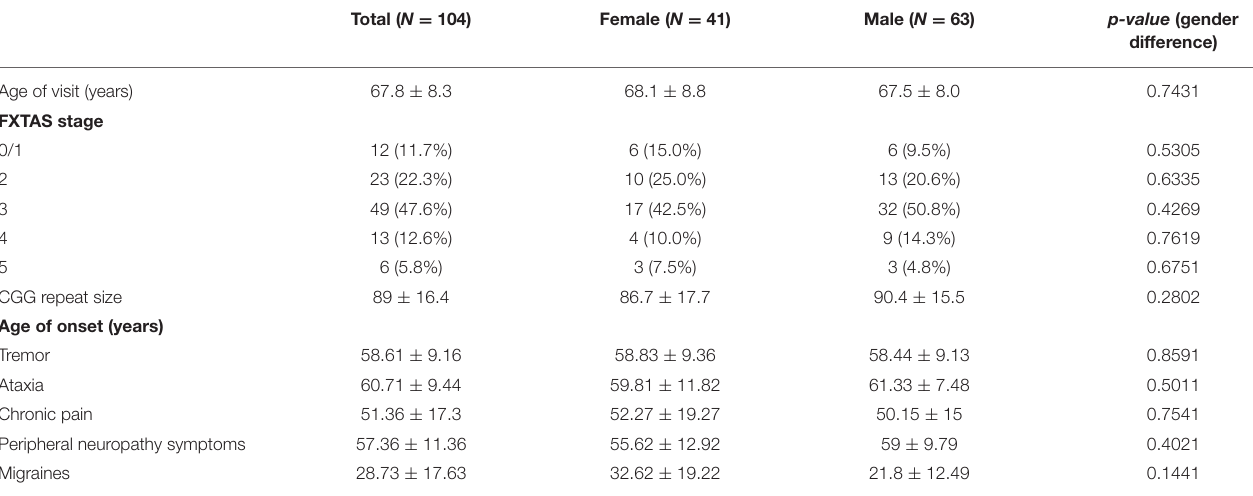
TABLE 1 | Summary statistics [Mean ± SD or N(%)] of patient characteristics and age onset (years) of symptoms.